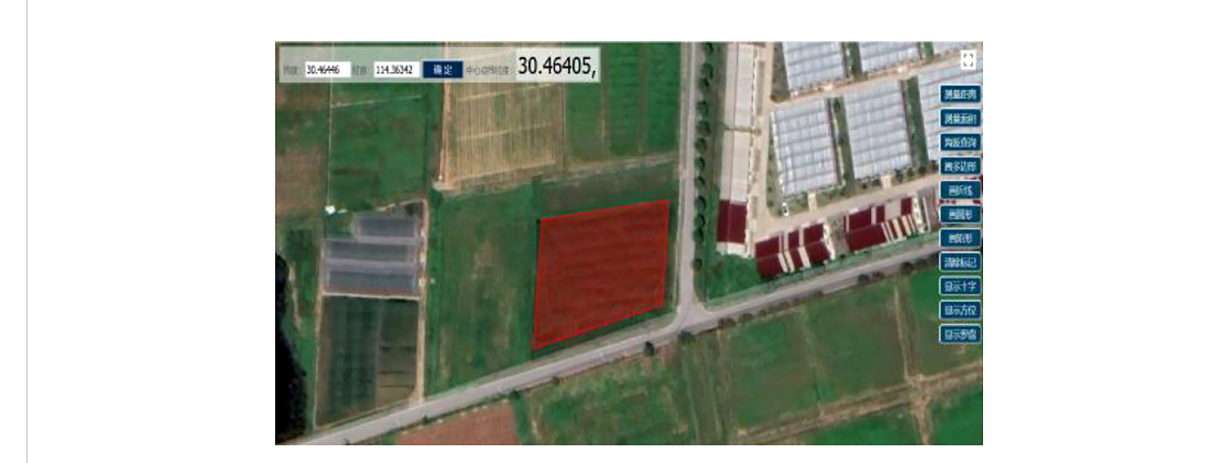
FIGURE 10 Satellite picture of irregular fi eld block.